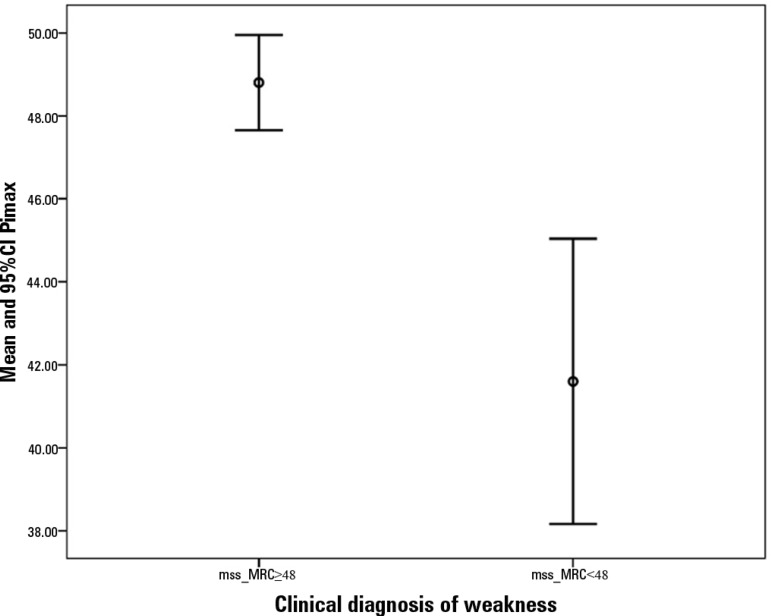
Error bars with means and 95% CIs of maximal inspiratory pressure
regarding patients with Medical Research Council muscle strength scale
values of ≥ 48 and < 48.95%CI - 95% confidence intervals; Pimax - maximum inspiratory pressure;
mss-MRC - muscular strength scale of the Medical Research Council.